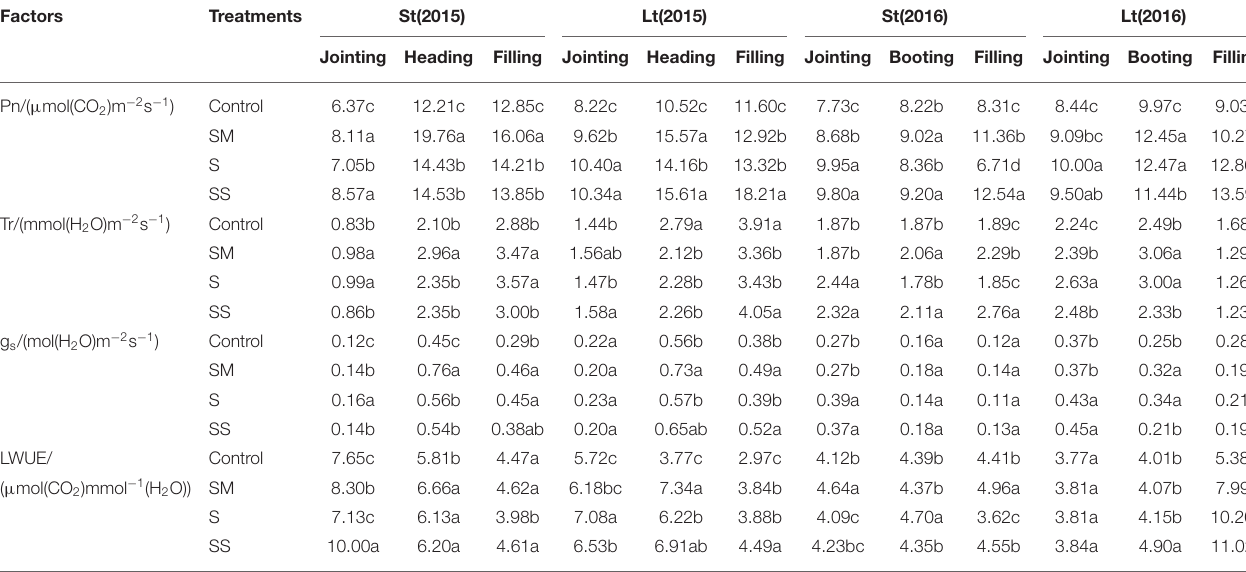
TABLE 2 | Photosynthetic characteristics in different growth stages of wheat under the Control, SM, S and SS treatments in different years. Factors